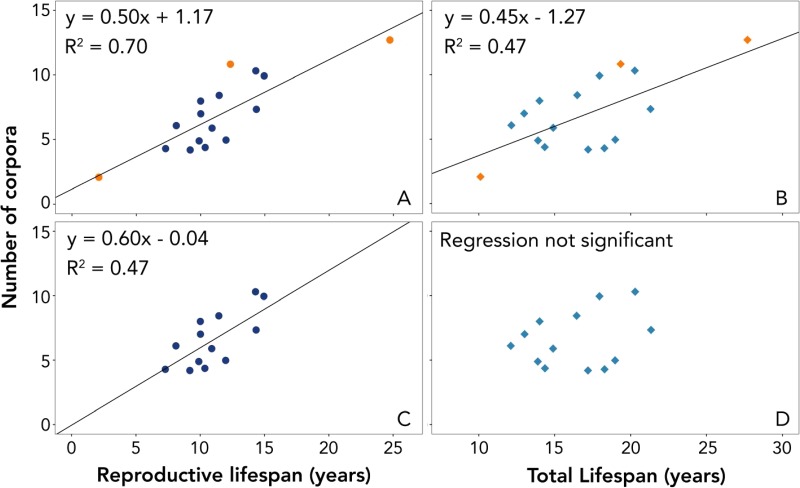
Regressions of number of corpora in walrus ovaries (total lifetime ovulations) against reproductive (A, C) and total lifespan (B, D). Top plots include all 16 available individuals with paired ovary and tooth data. Bottom plots show the same regressions with three individuals removed (two with change points with certainty code ‘C’ and one older animal with many corpora potentially acting as a leverage point). The greater R2 values of the regressions involving reproductive lifespan, as compared with those involving total lifespan, highlight the importance of agecp in predicting the total number of ovulations a female walrus will have in her lifetime.